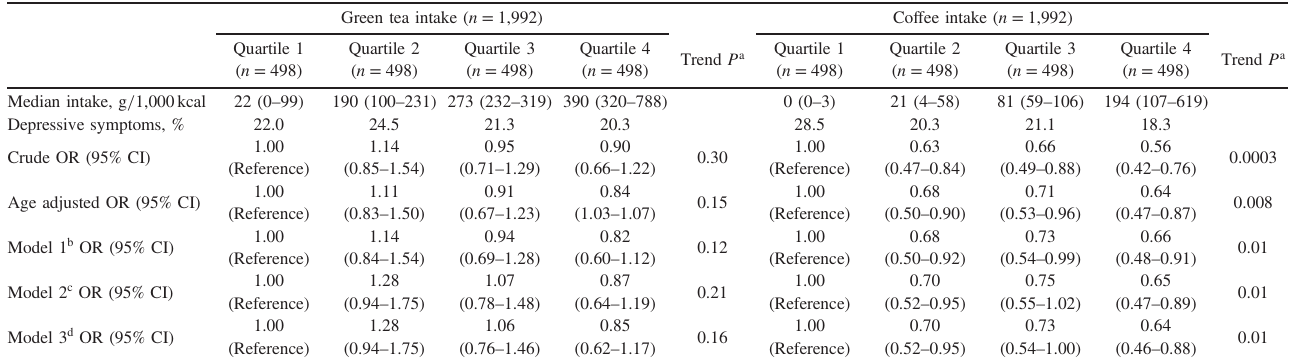
Table 2. Adjusted odds ratio (95% CI) of depressive symptoms according to intake of green tea and co ff ee in elderly Japanese